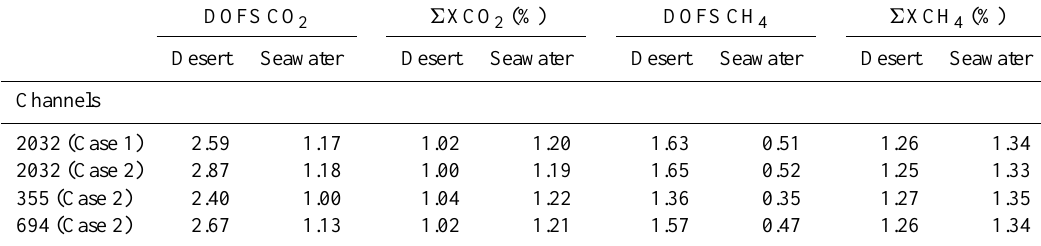
Table 5. Total DOFSs and column errors (%) of CO 2 and CH 4 for each surface from different amounts of selected